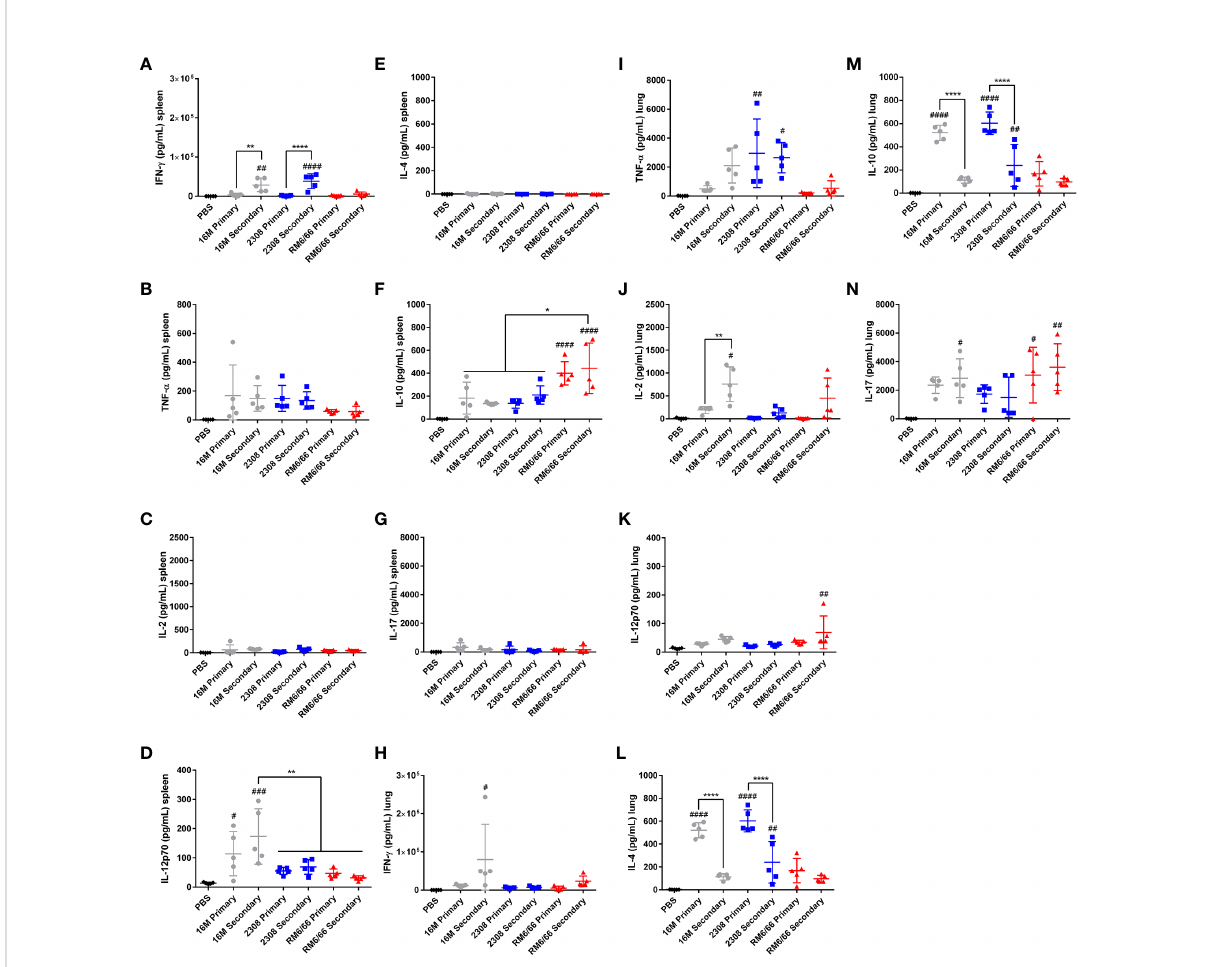
FIGURE 7 Secondary infection with B . abortus or B . melitensis , but not B . canis , results in a Th1 skewed cytokine response in the spleen and lungs. Measurement of cytokines in splenocyte culture supernatant after 48-hour stimulation with Brucella lysate from mice during primary or secondary infection with Brucella spp. (A) IFN- g , (B) TNF- a , (C) IL-2, (D) IL-12p70, (E) IL-4, (F) IL-10, and (G) IL-17. Measurement of cytokines in lung cell culture supernatant after 48-hour stimulation with Brucella lysate from mice during primary or secondary infection with Brucella